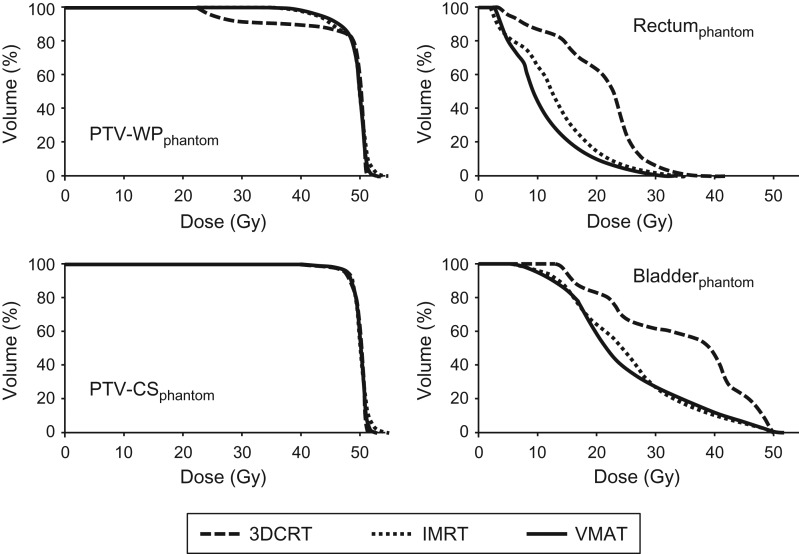
Dose–volume histograms of the PTV-WPphantom, PTV-CSphantom, rectumphantom and bladderphantom comparing 3DCRT plans, static-port IMRT plans, and VMAT plans in the phantom study.